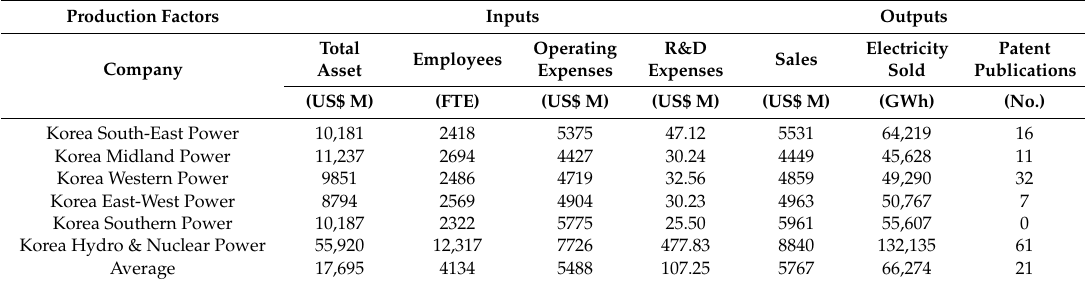
Table 3. Data of Korean Power Companies in 2018: An Illustrative Example.